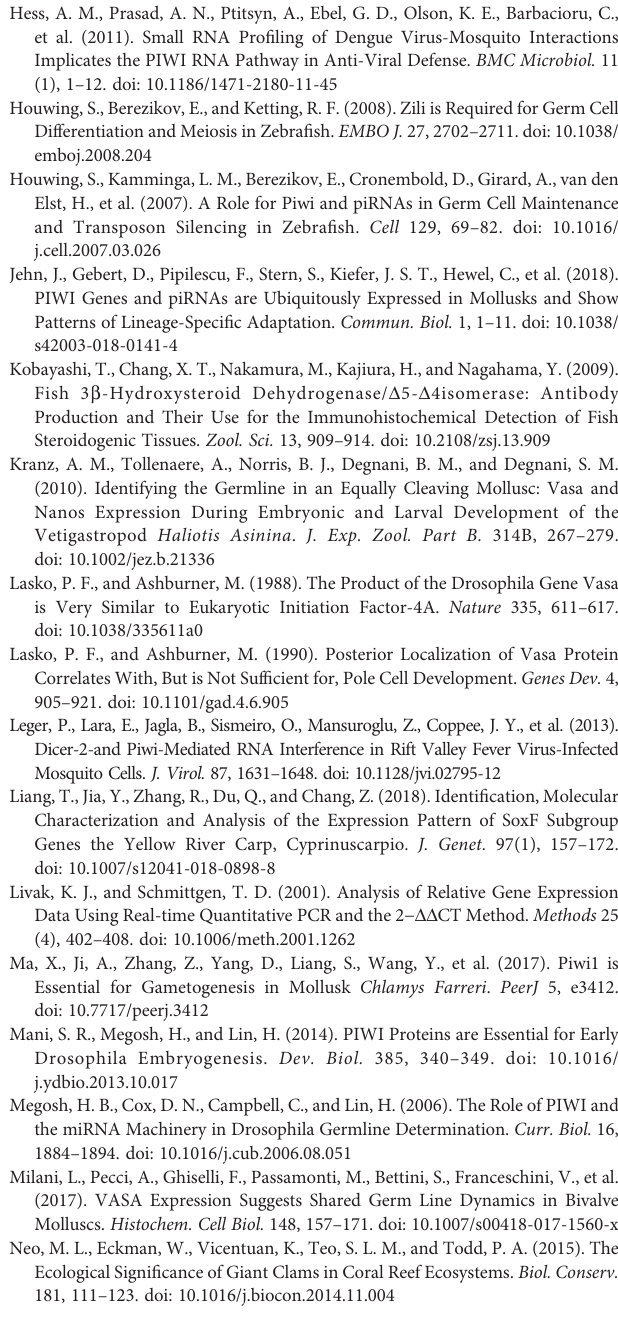
Supplementary Figure 1 | Full-length of the Tc-Piwi1 cDNA and its conserved domains of predicted amino acid in T. crocea . (A) The start codon and termination codon are in red, the sequence of predicted amino acid sequence is in blue, the PAZ and Piwi domain are shadowed and marked by black box, respectively. (B) Two conserved domains of Tc-Piwi1 in T. crocea